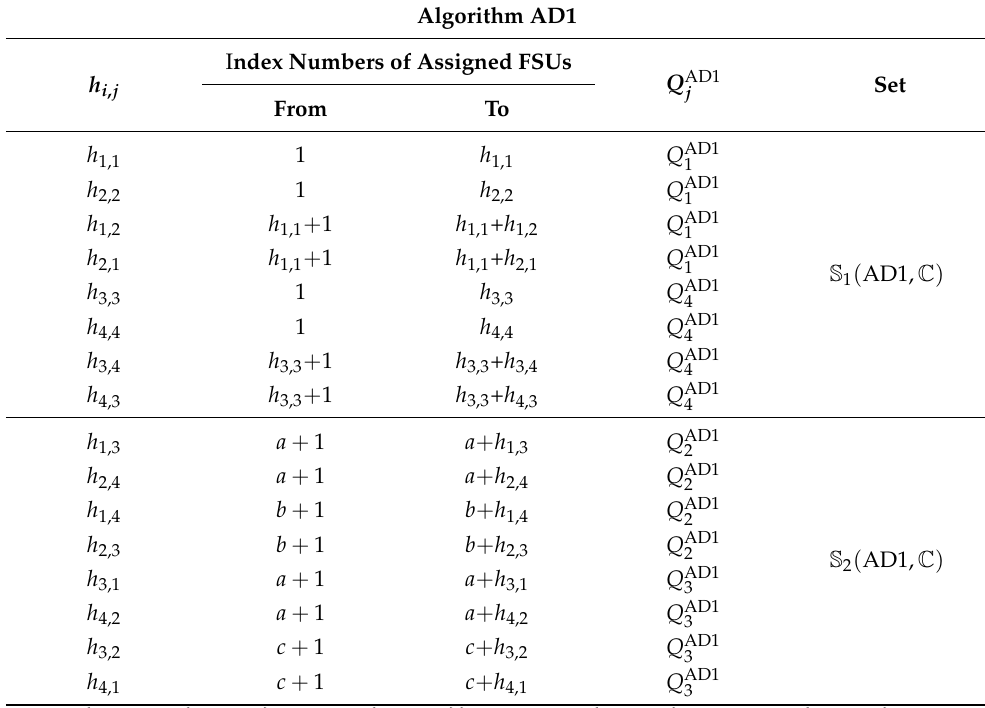
Table 1. Assignment of FSUs to connections by